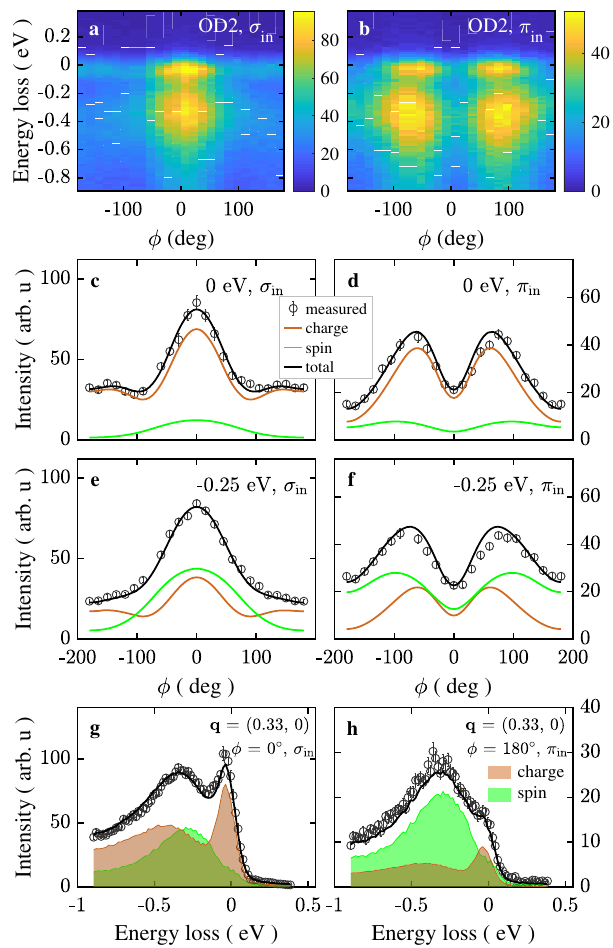
Fig. 2 Azimuthal-dependent RIXS spectra and the decomposition into the spin and charge contributions. a , b Azimuthal depen- dence of the low-energy RIXS spectra of the OD2 sample, measured with σ and π incident polarizations, respectively, and at an in-plane momentum transfer of q = (0.33, 0). c – f Constant-energy-loss cuts of the azimuthal-dependent RIXS intensity at 0 eV ( c , d ) and − 0.25 eV ( e , f ). The solid green and red lines represent the decomposed spin and charge components w s(c) ⋅ A s(c) ( ϕ ), respectively, and the solid dark lines are the sums of the two components. g , h The RIXS energy-loss spectra compared to the spin and charge components at grazing incidence ( ϕ = 0 ∘ ) with σ polarization and grazing emission ( ϕ = 180 ∘ ) with π polarization. The error bars represent the combined errors including the statistic errors and the errors in determining the zero-energy-loss positions (See